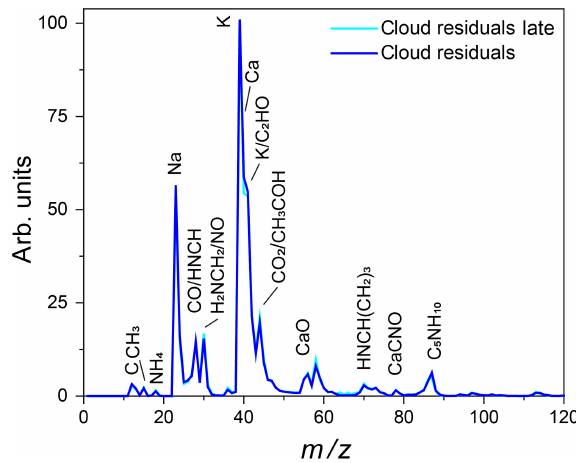
Figure 15. Average mass spectrum of cloud residuals measured dur- ing Expansion 3 (blue) with PF CGina bacteria super imposed on the average mass spectrum of particles characterized later in the ex- pansion (302–557s) when the number of sampled ice crystals and cloud droplets was comparable (light